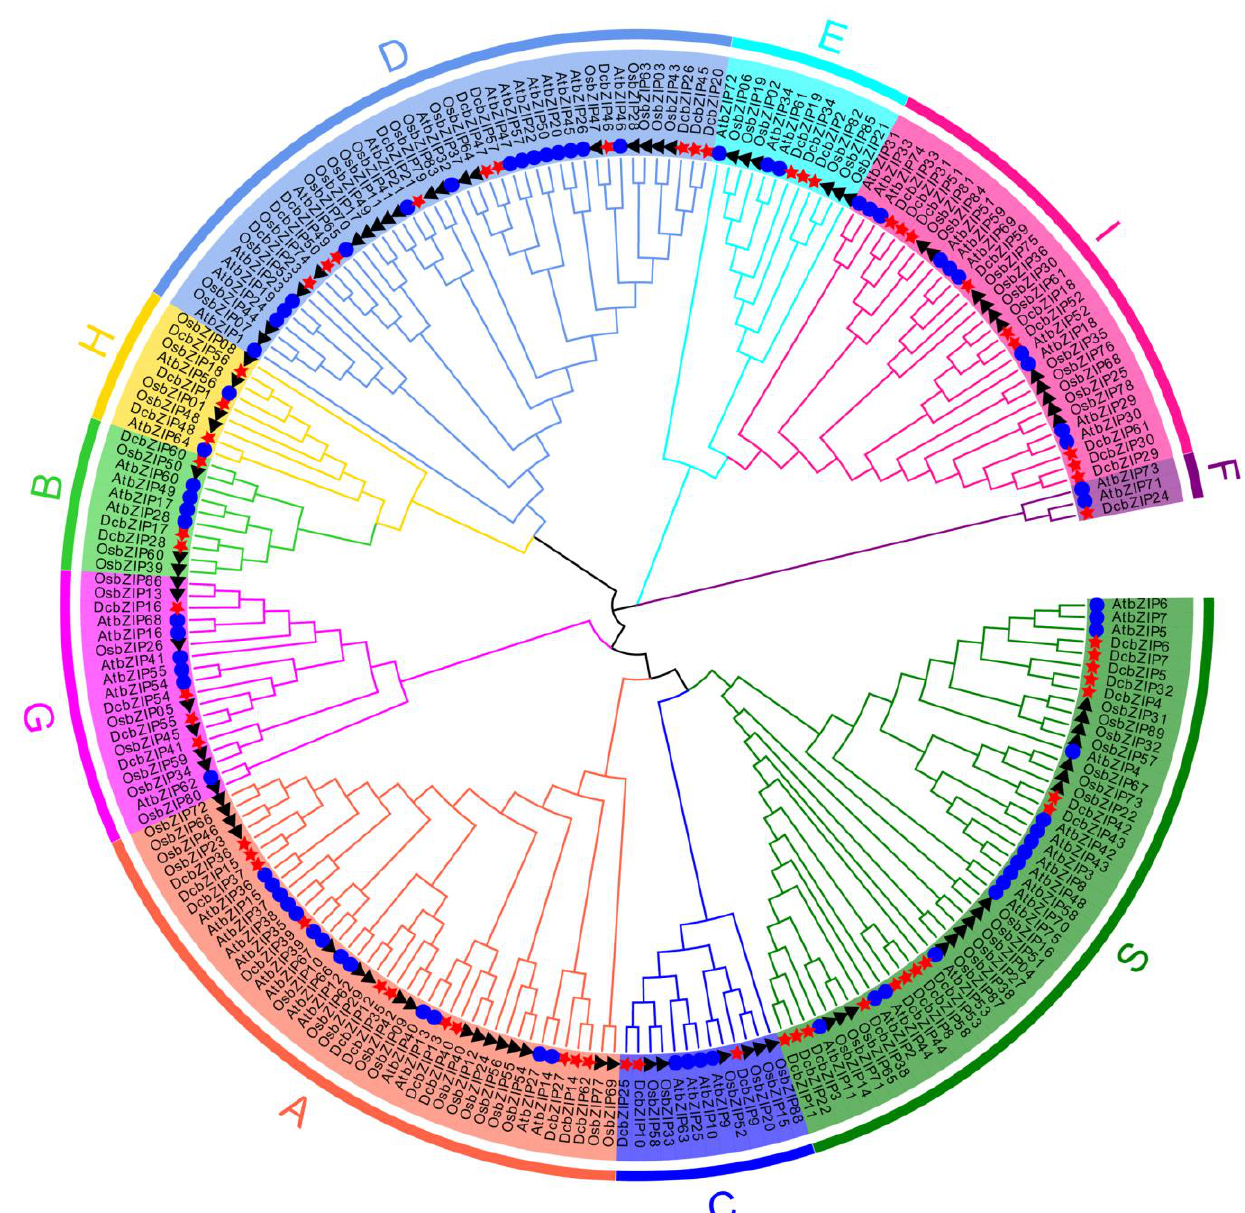
Figure 1. Phylogenetic analyses of bZIP proteins from D. catenatum , Arabidopsis and rice. A phylogenetic tree of bZIP proteins was constructed using MEGA 6.0 software. The 10 subgroups are indicated by different colors and different colored letters. The blue circles represent A. thaliana bZIPs (AtbZIPs), the red stars represent D. catenatum bZIPs (DcbZIPs) and the black triangles represent O. sativa bZIPs (OsbZIPs).